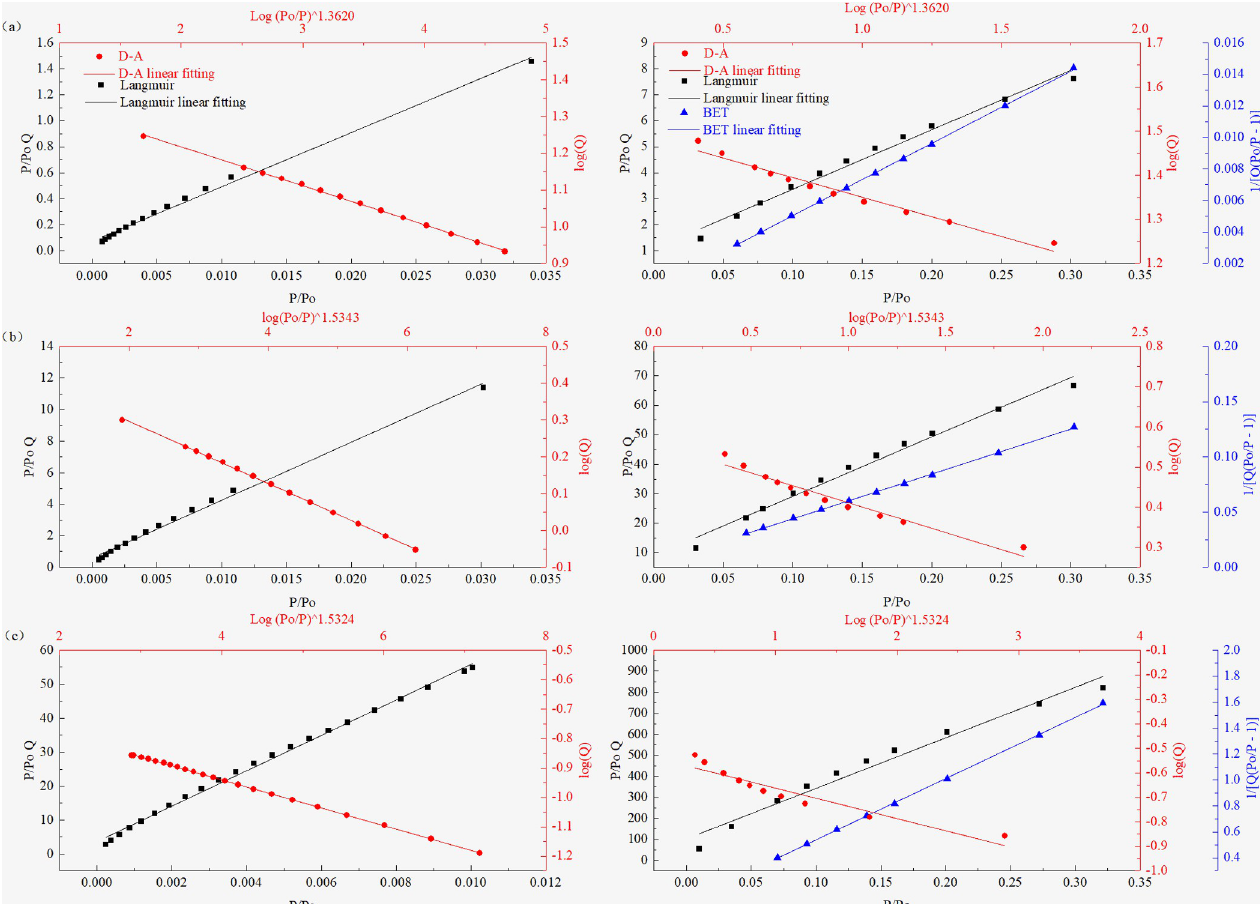
Fig 8. Fitting diagrams of coal samples of different coal ranks obtained using different models at different pressure sections. (a) PH Sample, (b) JB Sample, (c) LH Sample. (Left: Langmuir and DA model, Right: Langmuir, DA, and BET models).